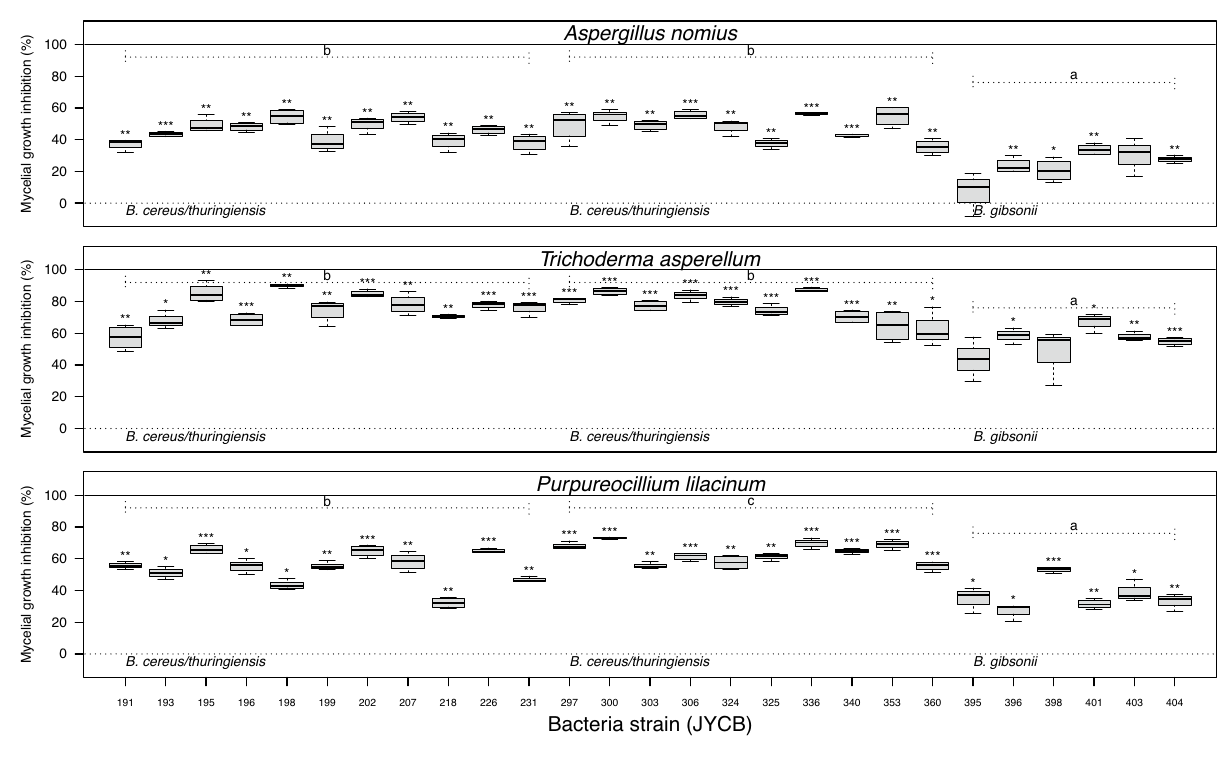
Figure 4. Mycelial growth inhibition (MGI) value of three entomopathogenic fungi under the effects of three predominant Bacillus strains isolated from ant cadavers infected by Ophiocordyceps unilateralis sensu lato. Letters indicate significant pairwise differences among the Bacillus species (Tukey’s all-pair comparisons using the beta regression model, p < 0.05). Starts indicate adjusted significant differences in comparing with